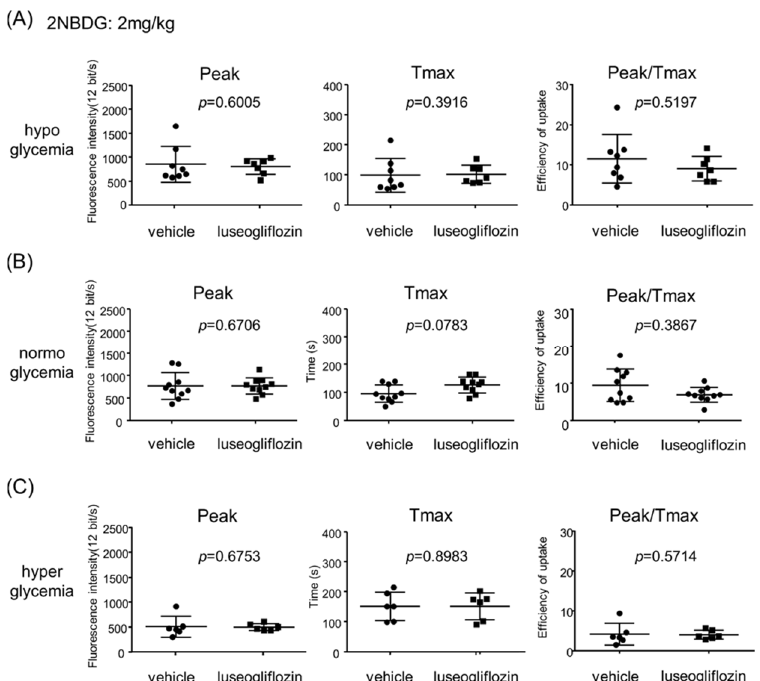
Figure 3. Effects of luseogliflozin on 2-NBDG (2 mg/kg) dynamics in early segments of proximal tubules. Peak, Tmax and peak/Tmax were compared under ( A ) hypoglycemic, ( B ) normoglycemic, and ( C ) hyperglycemic conditions. Each dot represents an average value from five proximal tubule cells in each mouse ( n = 7–10).